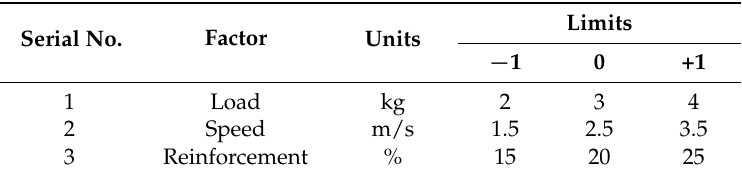
Table 4. Input data for different specimens.